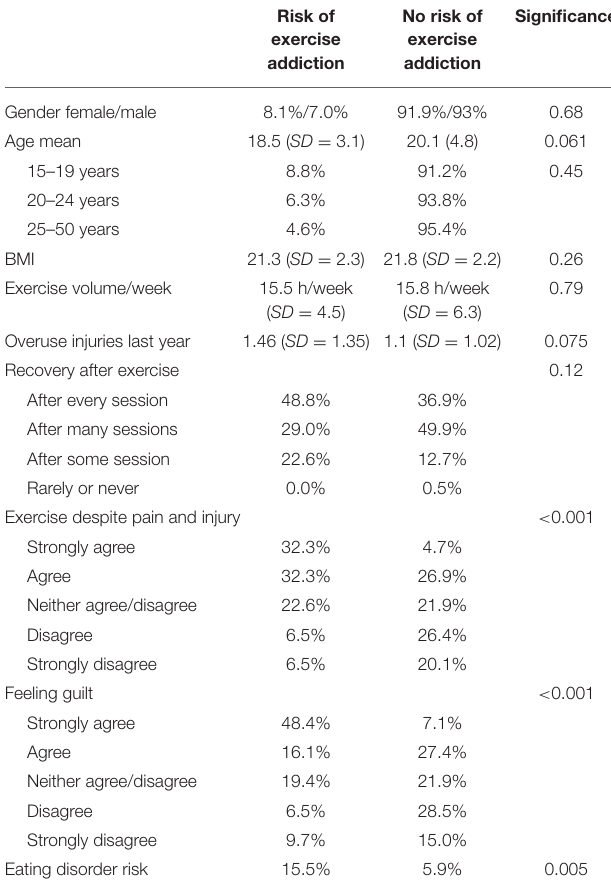
TABLE 2 | Characteristic of athletes with risk of exercise